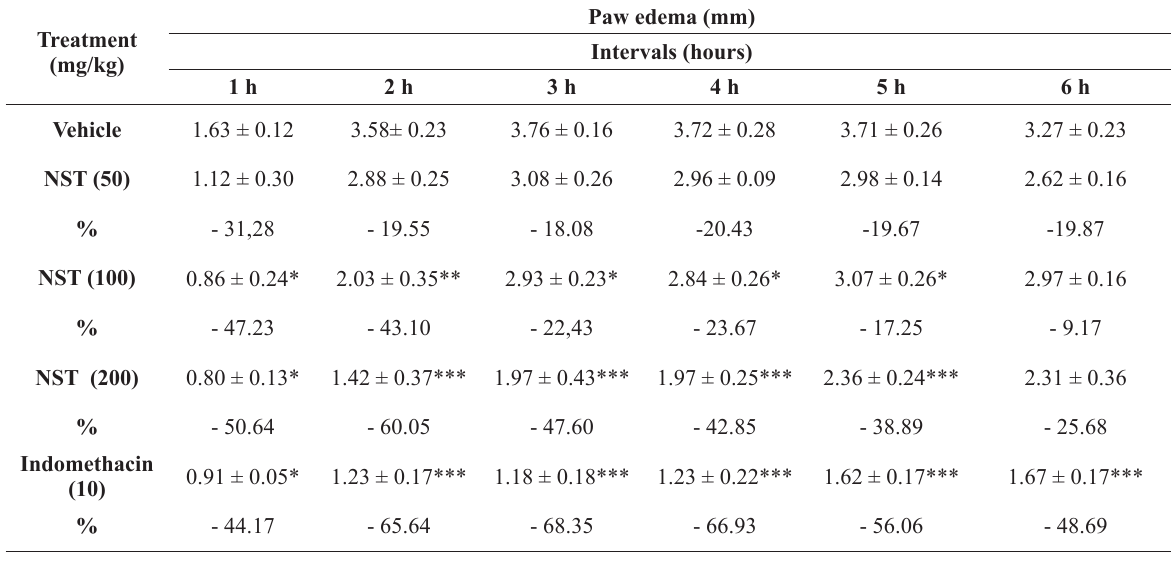
Effect of the NST (50, 100 e 200 mg/kg, i.p.), vehicle (NaCl 0.9% + 5% Tween 80), and indomethacin (10 mg/kg i.p.) on carrageenan-induced paw edema in rats (1 %; 0.1 mL, i.pl.). The values are presented as mean ± SEM. * p <0.05, ** p <0.01 and *** p <0.001 compared with vehicle group (NaCl 0.9% + 5% Tween 80). Two-way ANOVA followed by Bonferroni’s post-hoc test.